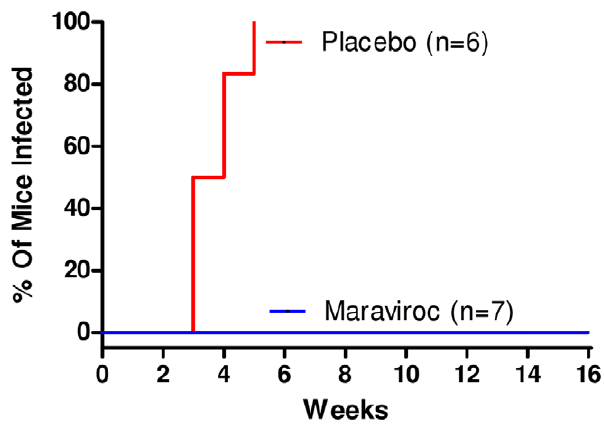
Figure 1. Vaginal application of maraviroc gel protects humanized mice against vaginal HIV-1 challenge. RAG-hu mice were challenged by vaginal route one hour after vaginal administration of maraviroc as described in Methods. Blood was collected weekly from infected mice and the status of HIV-1 infection was determined by Q-RT-PCR. Kaplan-Meier plots of time course of appearance of viremia in drug treated versus non-treated virus challenged mice.